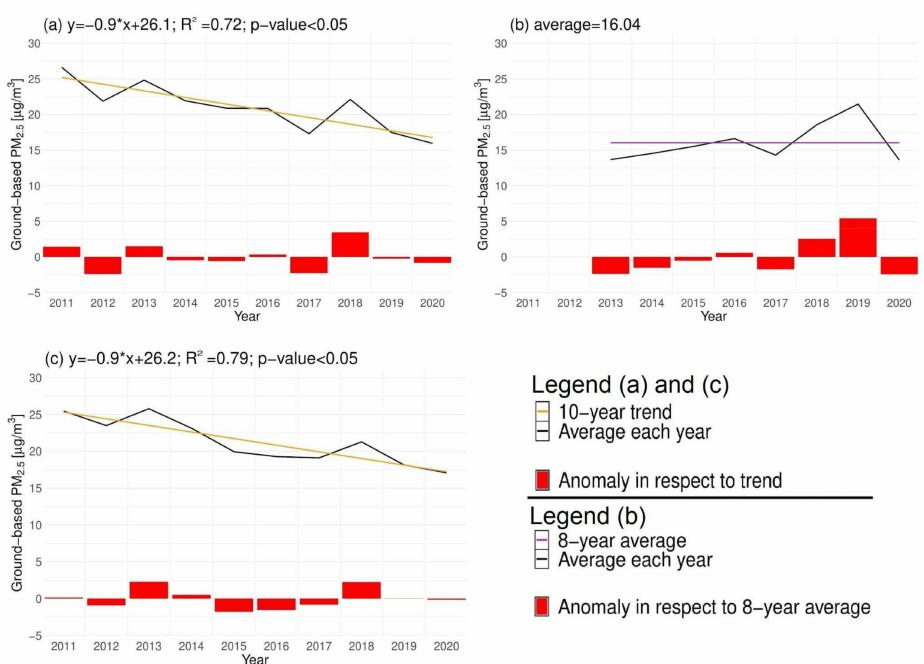
Figure 8. March to June mean ground-based PM 2.5 concentrations ( µ g/m 3 ) (black line: ( a – c )), linear regression (orange line: ( a , c )) and anomalies (red bars: ( a – c )) with respect to trends over: ( a ) urban areas ( b ) non-built-up areas; ( c ) Warsaw. For statistically insignificant trends, anomalies with respect to averages were calculated (purple line: ( b